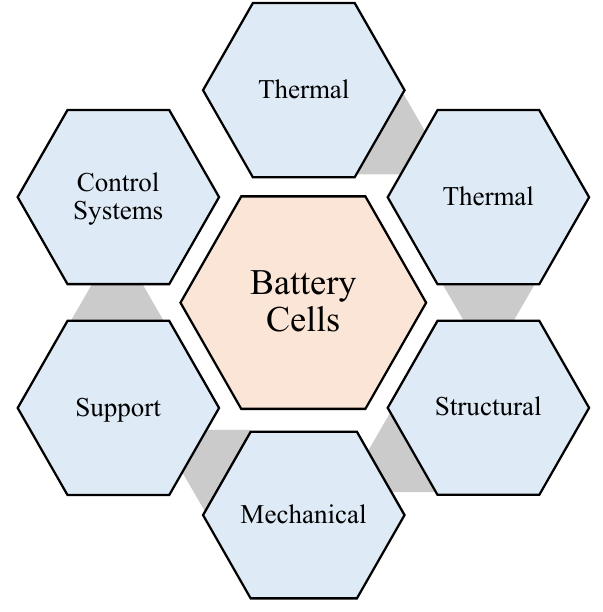
Figure 3. System boundary interface for a battery pack [34].